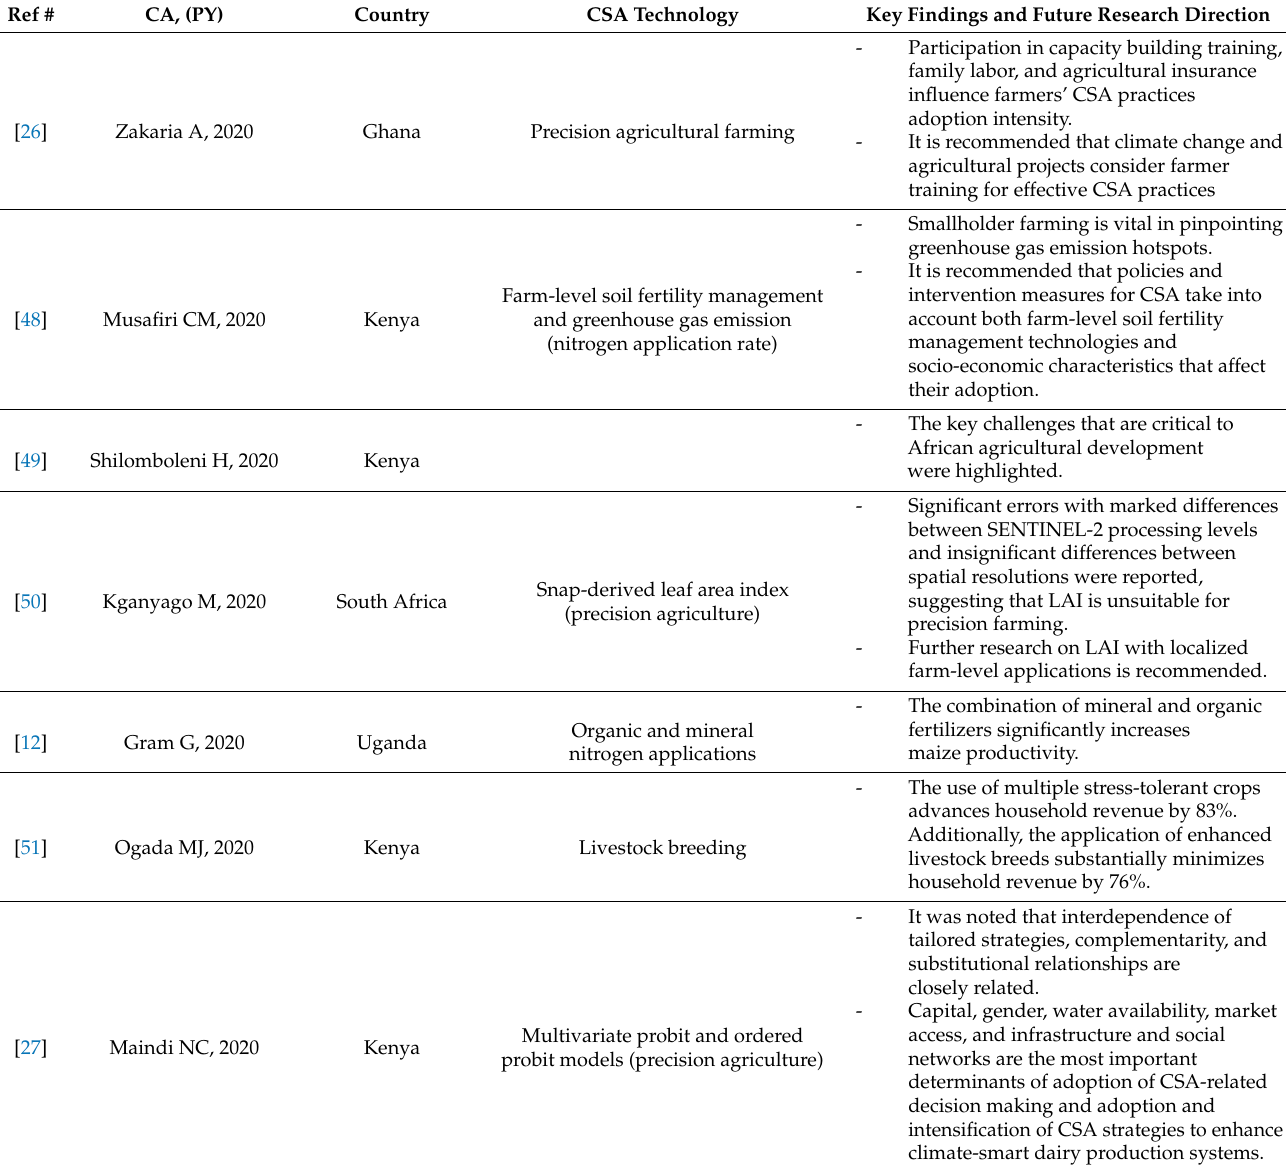
Table A1. A summary of selected scientific publications on climate-smart agriculture studies in Africa published from 2000 to 2020. The information is only limited to published scientific articles. Hence, conference papers, proceedings, reviews, and books/book chapters are excluded in the summary. CA—corresponding author; PY—publication year, Ref #—reference